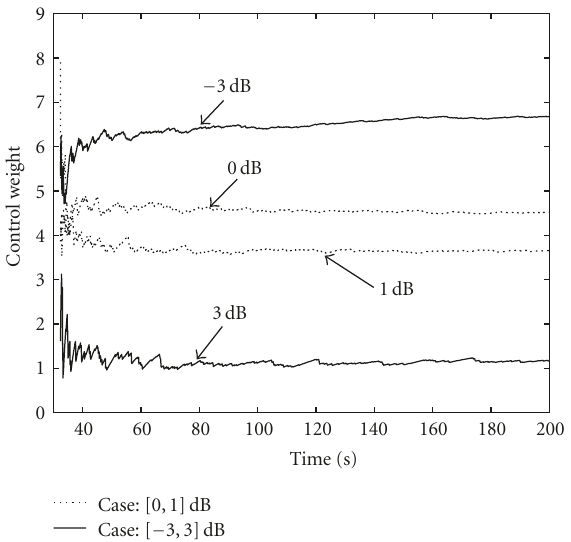
Figure 3: The convergence of w i ’s for di ff erent users and di ff erent SNR ranges (MAX-FAIR).